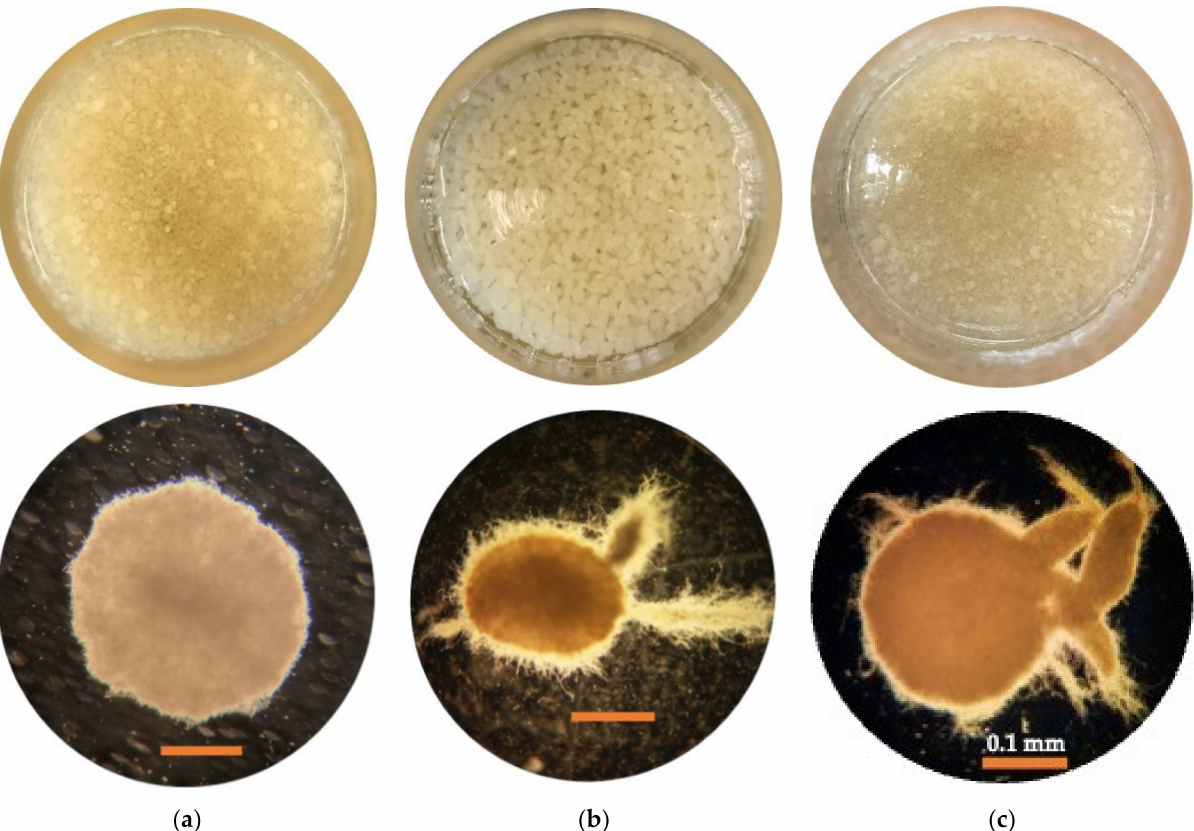
Figure 6. Macroscopic (above) and microscopic (below) (under microscope 4 × obj) for morphological analysis of mycelium pellet of L. rhinocerus strain ABI in optimized media conditions for responses ( a ) MB, ( b ) EPS, and ( c ) MB and EPS. The bars indicate 0.1